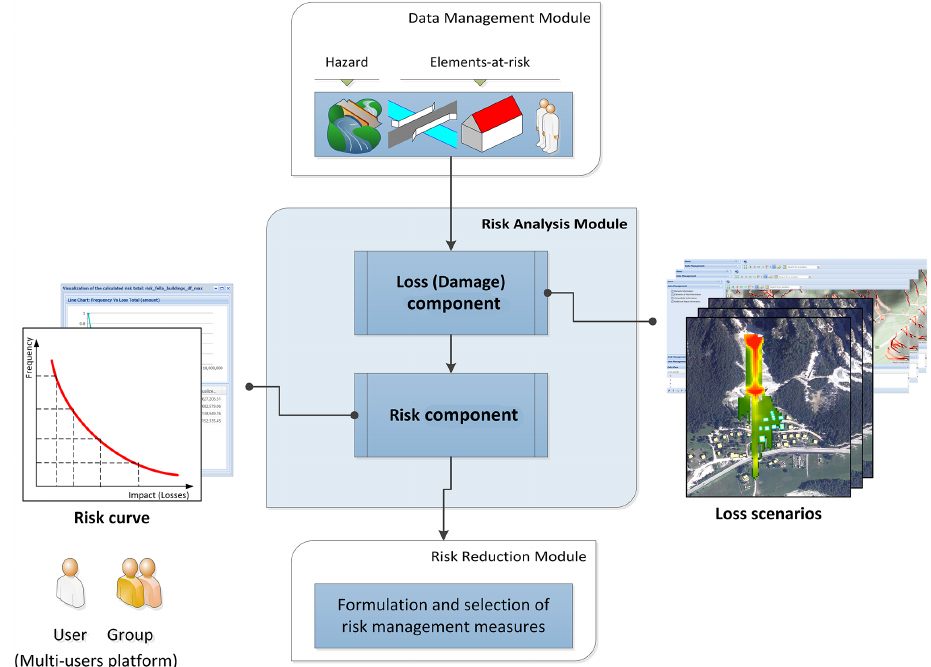
Figure 1. Overview diagram illustrating the main modules of the prototype web-GIS platform. For the user interactions, the risk analysis module is mainly intended for expert users (risk managers) while various stakeholder groups can be involved in the risk reduction module for the decision-making process in the formulation and selection of different risk management